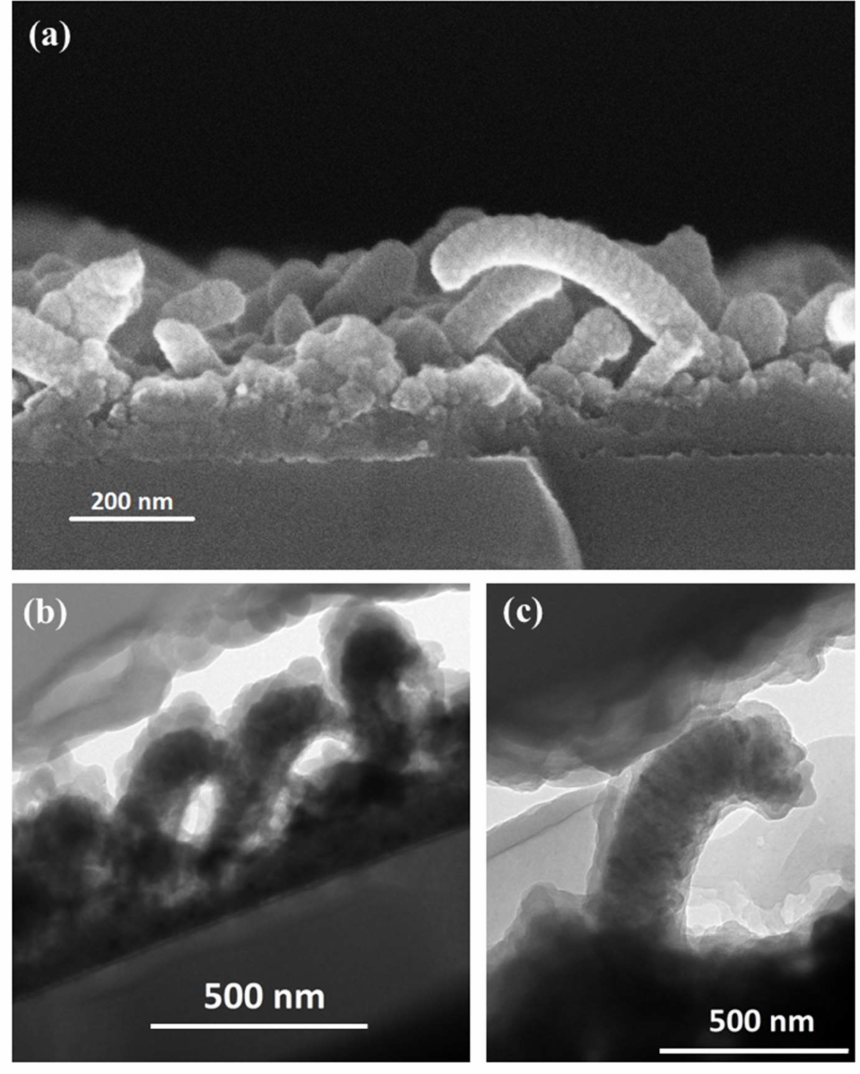
Figure 5. ( a ) SEM and ( b , c ) TEM microscopies in cross view of 100 nm thick AZO showing the conformal deposition of the oxide layer, the curved morphology of the nanostructure after the deposition and the inner silicon core with the AZO shell ( b , c